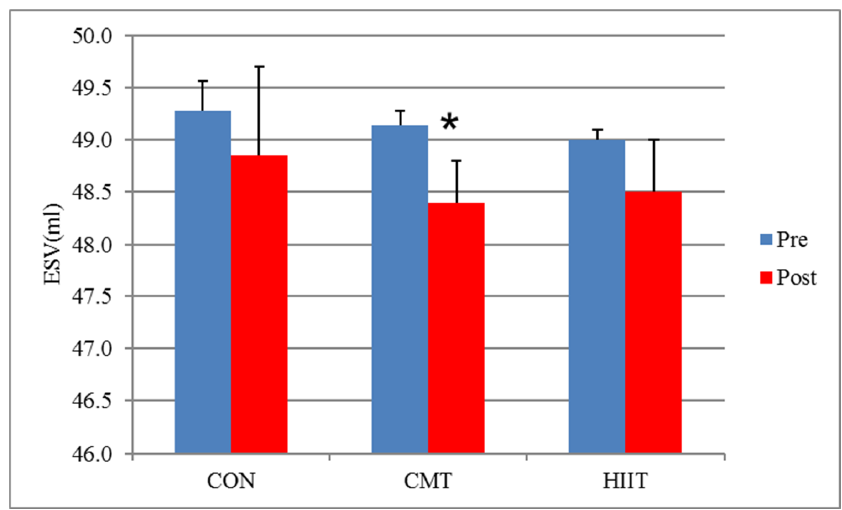
Figure 1. ESV Changes before and after 12 Weeks of CMT and HIIT; * Indicates a significant decrease compared with the HIIT and control groups ( p < 0.05). ESV: End Systolic Volume (mL). CON: Control. CMT: Continuous Moderate Training. HIIT: High Intensity Interval Training.